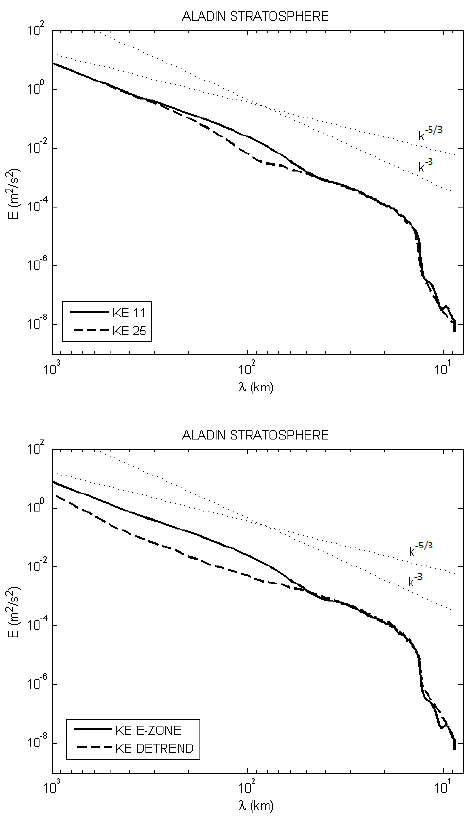
Figure 1. Kinetic energy spectra of the ALADIN/SI model with 4.4km horizontal resolution, averaged over model levels between 5 and 250hPa. Top: comparison of ALADIN spectra with 11 and 25 points in the E zone. Bottom: comparison of ALADIN de- trended spectra and spectra with E zone. The dotted lines have slopes (k ∗ ) − 3 and (k ∗ ) − 5 / 3 where k ∗ is the one-dimensional wave